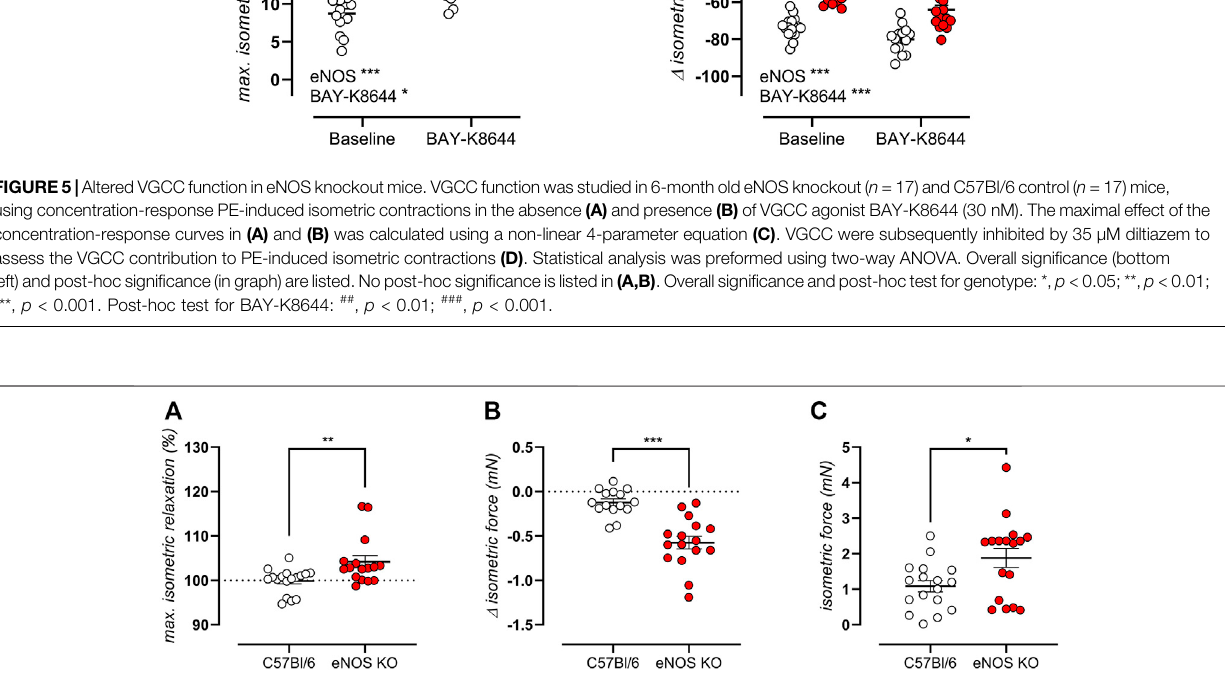
Frontiers in Physiology |